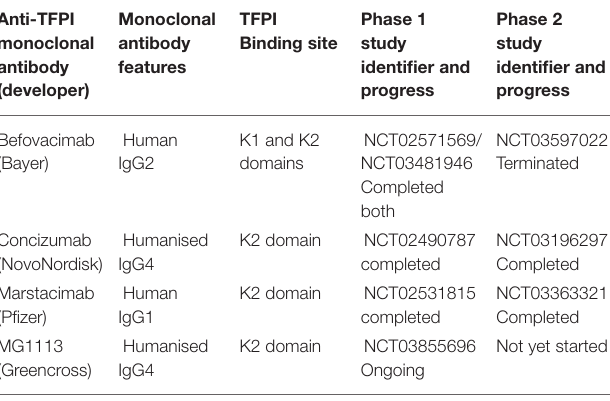
TABLE 1 | Characteristics and progress in the development of anti-TFPI monoclonal antibodies. Anti-TFPI monoclonal antibody